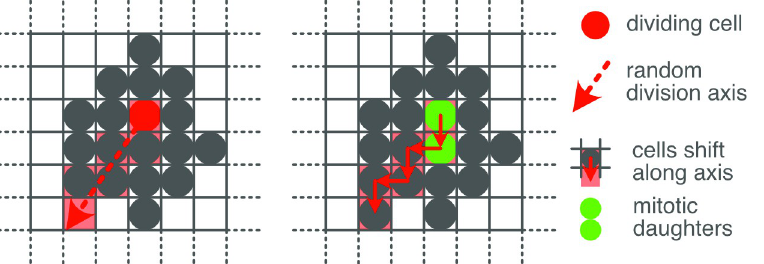
Fig 10. Illustration of cell placement. Although the illustration is 2D, the placement is the same for 3D. When a cell divides a random division axis is drawn uniformly from a unit circle (in 2D) or sphere (in 3D). Then, the sequence of cells that intersect the division axis are shifted along the sequence to create a free slot next to the dividing cell. The mitotic daughters take the original slot of the parent, and the newly created free slot.